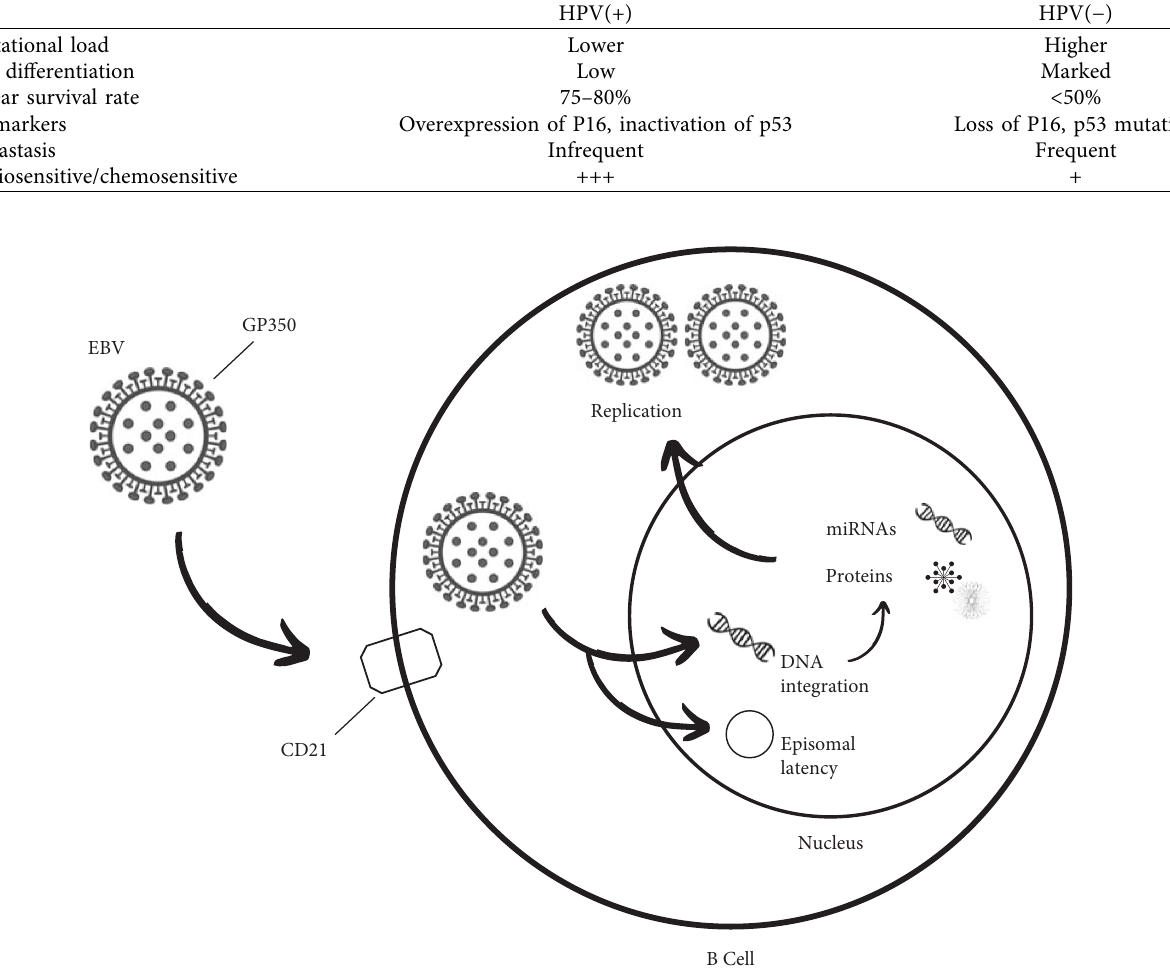
Figure 2: Mechanism of EBV infection: EBV accesses the B lymphocyte, where it can enter a replicative cycle producing virions or it can remain as a latent infection, persisting throughout the individual’s